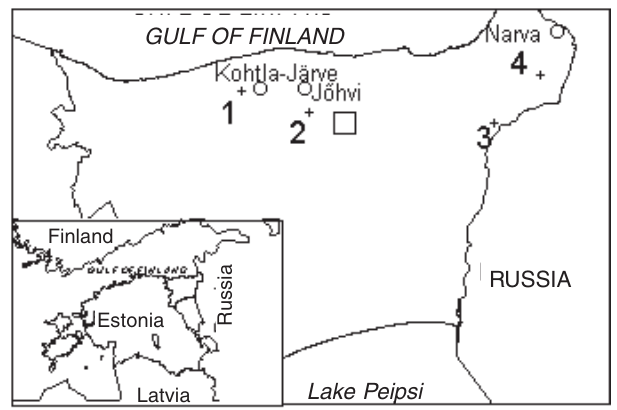
FIGURE 1. The study area: northeastern part of Estonia. The power plants (+): 1, Kohtla-Järve; 2, Ahtme; 3, Estonian; 4, Baltic. Box ( ¨ ) indicates Kurtna Landscape